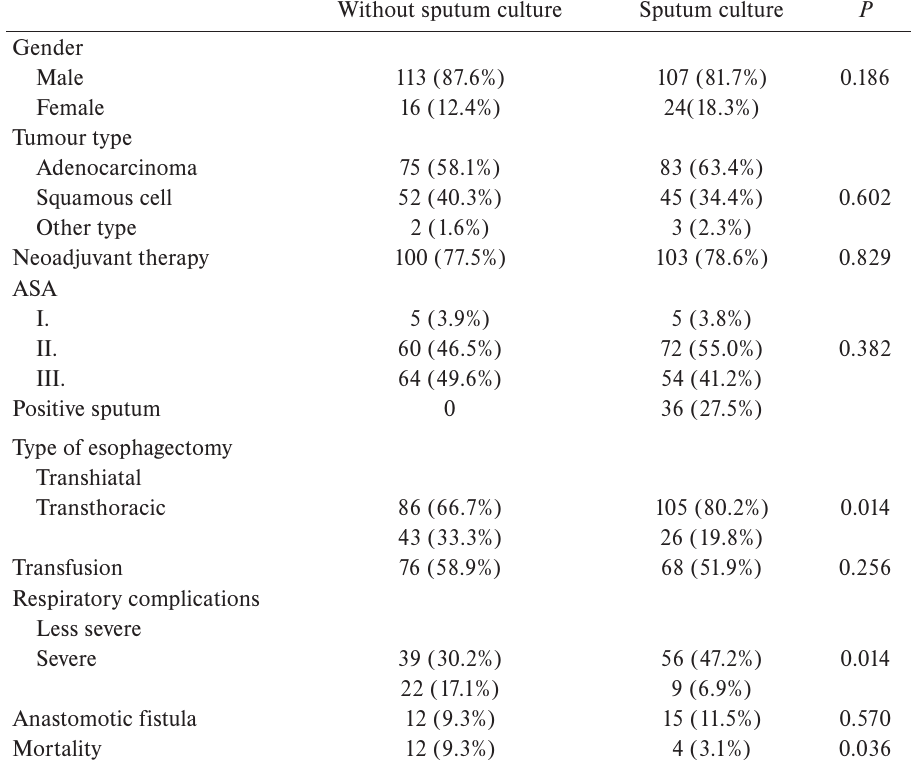
Table 3. Comparison of results between patients without sputum culture from 2006–2011 and patients with sputum culture from